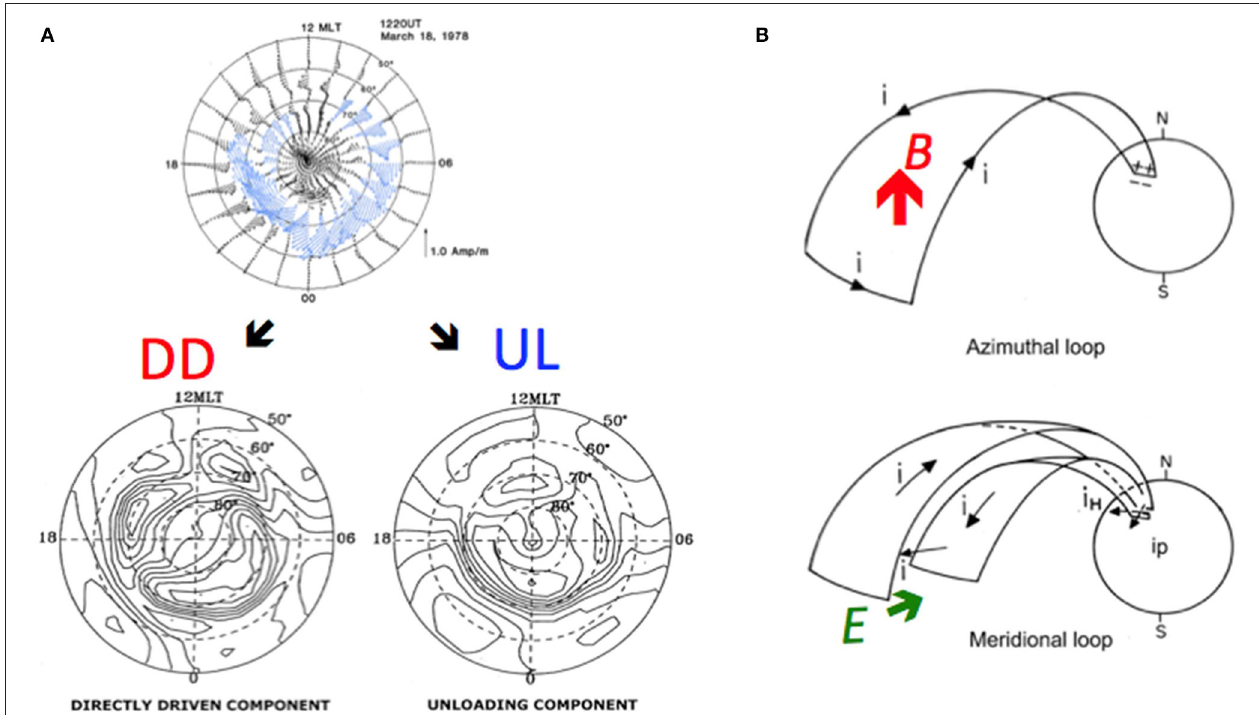
FIGURE 9 | (A) the polar current deduced from the ground-based magnetometers is separated into two components, the directly driven (DD) by the solar wind-magnetosphere dynamo and the current generated by the unloading (UL) for the expansion phase (the same as Figure 7B ). (B) the 3-D UL current system of the expansion phase was proposed by Bostrom (1964); the UL current in Figure 9A is the ionospheric part of the equivalent 3-D current system, which is produced by an earthward electric field (the green arrow E ) as shown here (section A possible process for generating the earthward electric field). The red arrow (B) indicates the magnetic field produced by the azimuthal component of the 3-D current system which will be responsible for the poleward advance of the aurora and the auroral electrojet (section The Poleward Advance of